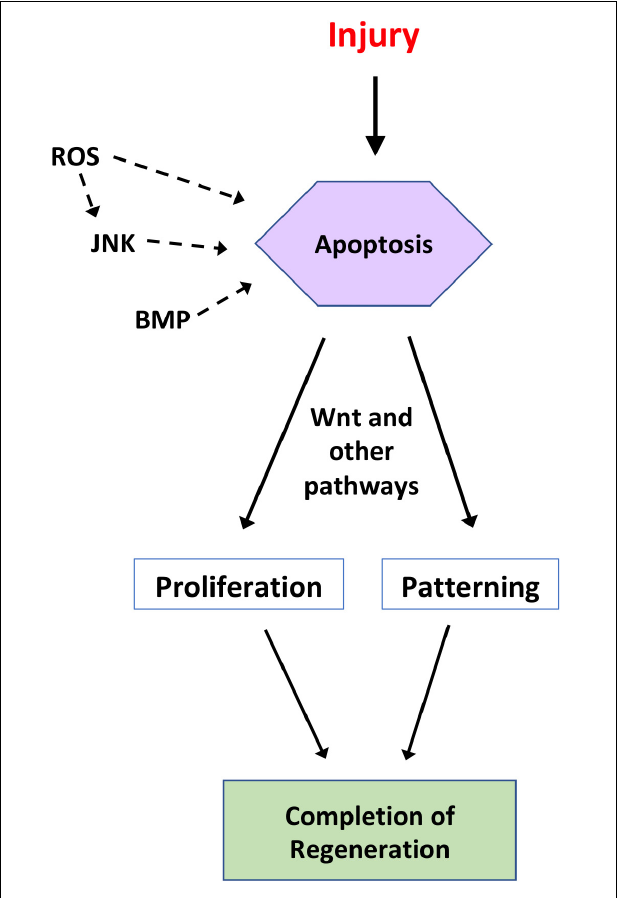
FIGURE 1 | Summary of the regulation and roles of apoptosis during regeneration. Following injury to a tissue, apoptosis can act as a regenerative mechanism, depending on the organism and tissue in question. In some regenerative systems, apoptosis is regulated by ROS, JNK, and/or BMP signaling. In turn, apoptosis regulates proliferative and/or patterning signals, such as Wnt signaling, to drive initiation and completion of regeneration. This figure is not intended to be comprehensive and represents an amalgamation of studies from several model systems discussed in the